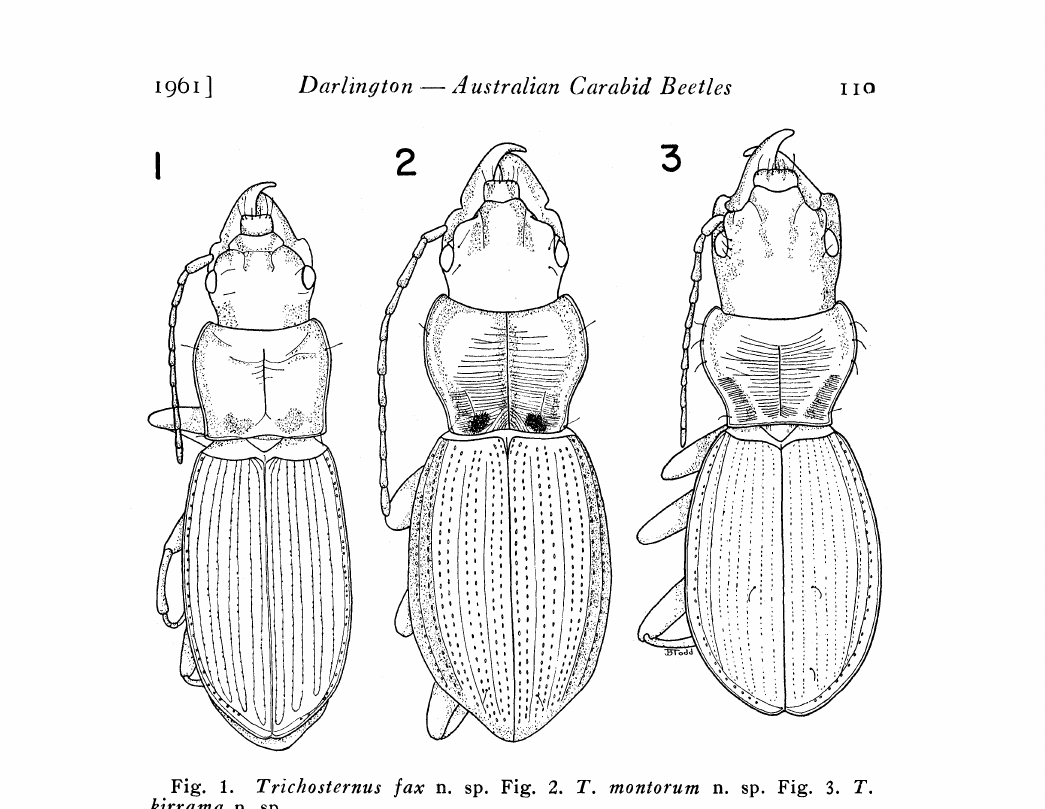
Fig. 1. Trichosternus fax n. sp. Fig. 2. T. montorum n. sp. Fig. 3. T. kirrama n. sp. line deep, transverse impressions almost obsolete, except for subbasal t:oveae each side midway between middle and sides, separated rom margins by strong convexities; disc and foveae not punctate. Elytra c. I/5 wider than prothorax, usually slightly narrowed anteriorly; margin rectangular or almost acute at subdentate humeri; elytra with striae well impressed and punctate; intervals slightly convex but not costate, 3, 5, and 7 slightly wider than others but not more elevated, except 7th slightly elevated at base; narrow oth interval indicated posteriorly; dorsal punctures lacking. Mesosternum anteriorly and , prosternal process setose. lale tront tarsi slightly dilated, 3 segments squamulose; cf with 2 setae each side last ventral segrn,ent. Length 2o-23; width 6.5-7.7 ram. Holotype cf (M. C. Z. Type No. 3o,355) and I5 paratypes all from Mt. Bartle Frere, North Queensland, west slope 3ooo-5ooo ft. (not tound lower), Dec. 957, collected by my wife, my son, and myself, in mountain rain